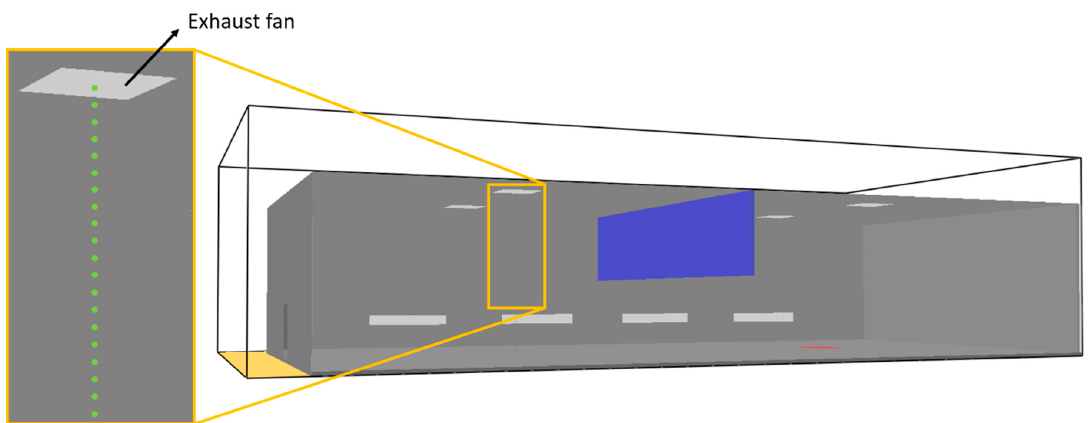
Figure 4. Location details of the temperature and soot mass fraction measurement points inside the system.